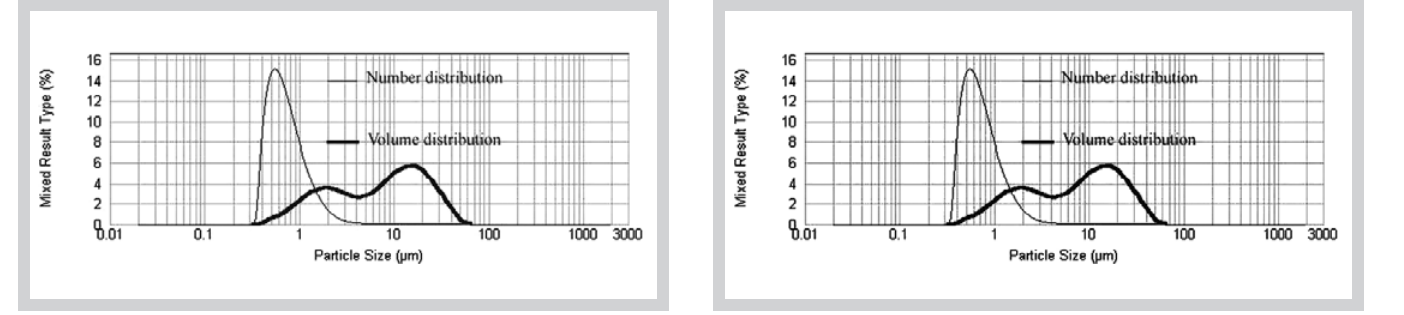
Figure 1 (left): Number and volume size distribution of resin A. Figure 2: Number and volume size distribution of resin